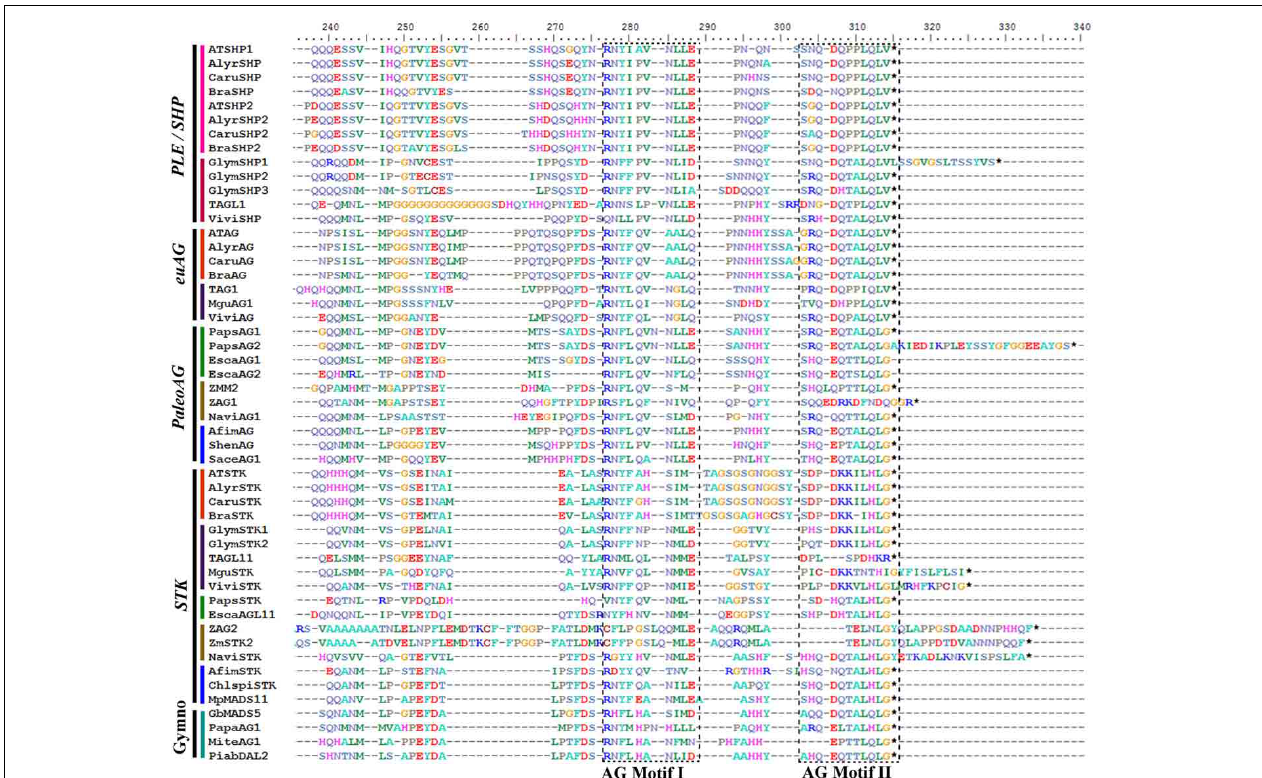
FIGURE 4 | Alignment of the end of the K and the complete C-terminal domain of AGAMOUS/SEEDTICK proteins (labeled with the clade names they belong to). Colors to the left of the sequences indicate the taxon they belong to as per the color key in Figure 5 . Previously identified conserved AG Motifs I and II in both protein clades are boxed; note that sequences in between the motifs are very different between the AGAMOUS